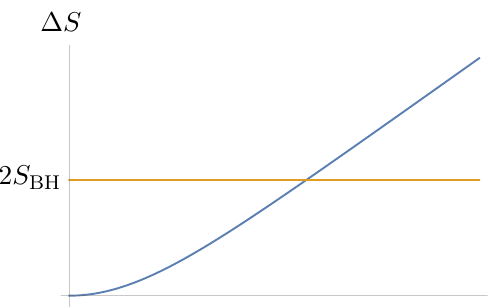
Figure 24. Page curve for the equilibration of our topological black hole in d = 2 . We plot the entropy ∆ S = S ( t ) − S (0) of the subregion on the CFT which is associated to the radiation, where we subtract the value of the entropy at t = 0